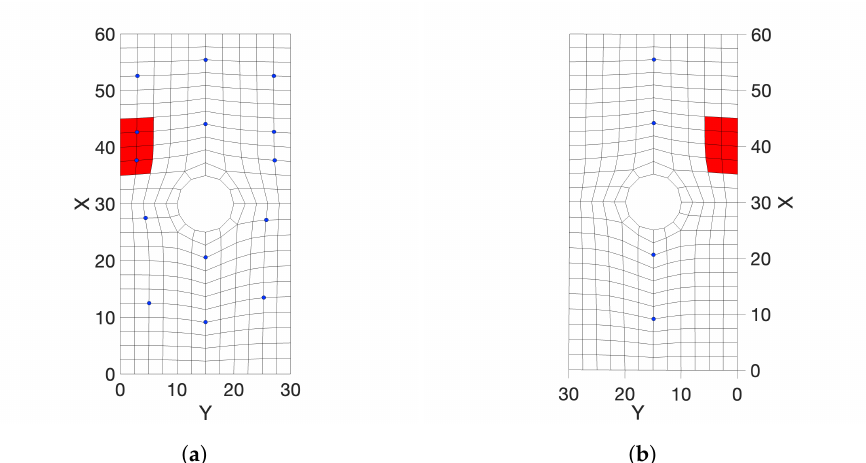
Figure 9. Damaged region (red) and location of the 18 sensors (nodes highlighted in blue). ( a ) Top view; ( b ) bottom view.